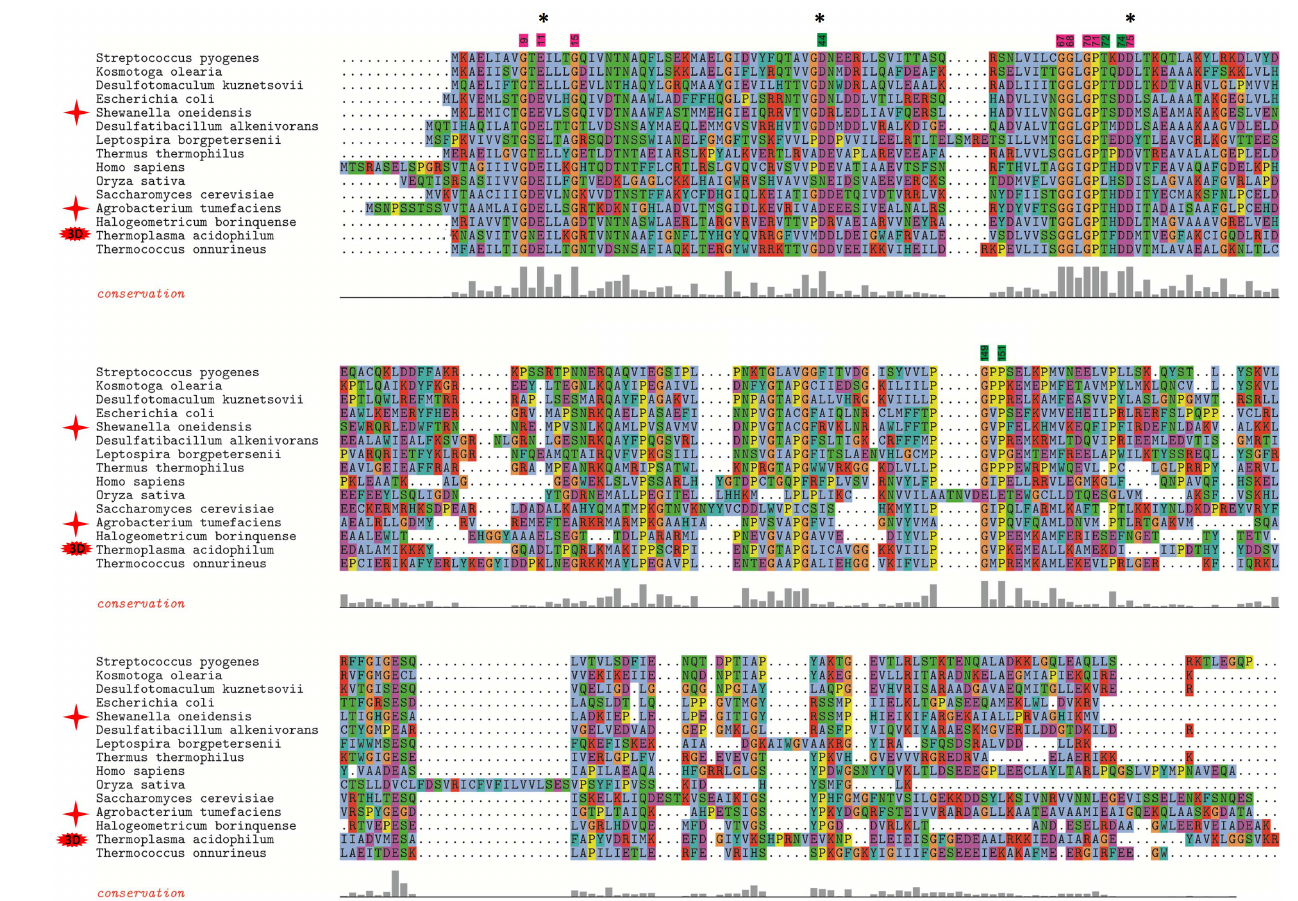
Figure 8. Multiple sequence alignment of selected COG1058 proteins. Multiple alignment of representative members of the COG1058 family (full version is available in Figure 2). Positions of residues conserved in all members of the family are highlighted at the top of the alignment in magenta. The residues highlighted in green are conserved in all proteins, with the exception of the plant subfamily. Residues are numbered according to the T. acidophilum protein. Proteins experimentally characterized in this work are marked by red stars. Residues mutated in the A.tumefaciens protein are marked with black asterisks.